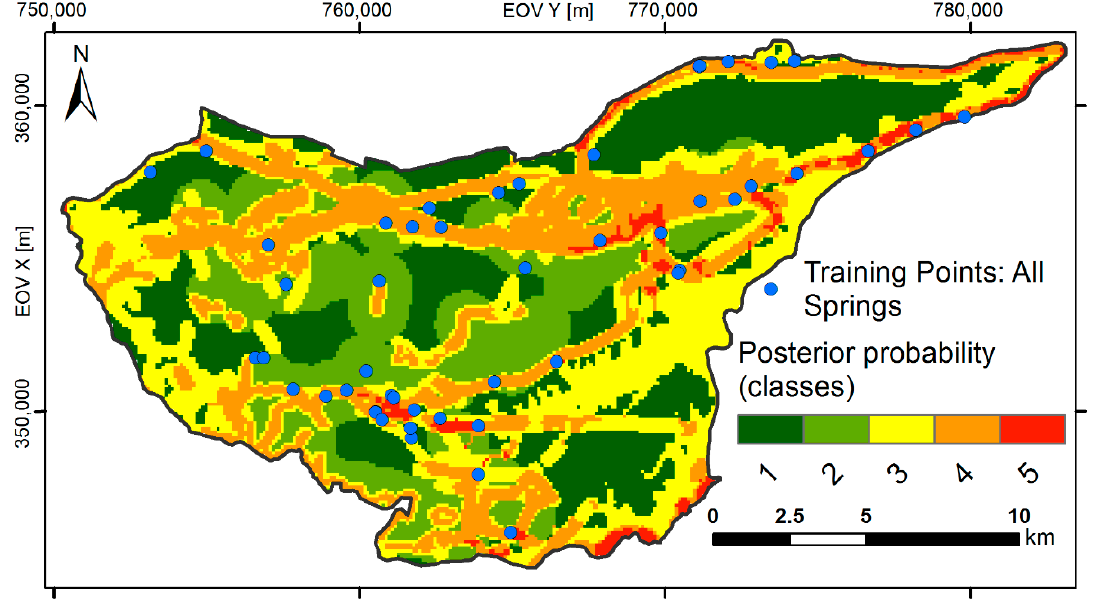
Figure 6. Posterior probability map: the relative probability of finding springs.